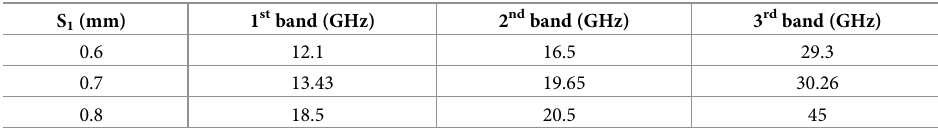
Table 4. Simulated result of quality factor for different values of S 1 .